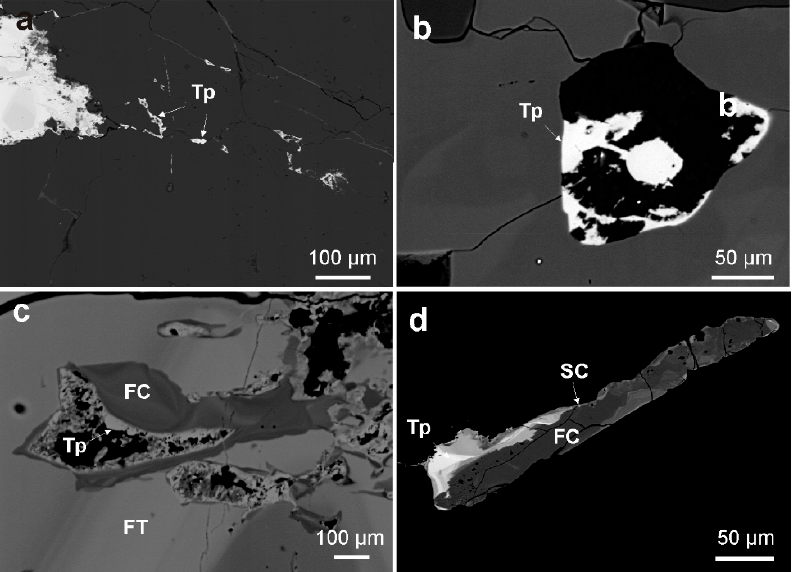
Figure 14. Textural patterns of tapiolite from type-IV pegmatites. ( a ) Tapiolite (Tp) filling fractures in quartz. ( b ) Tapiolite (Tp) filling a void in quartz produced by dissolution of a pre-existing mineral. ( c , d ) Replacement of columbite-(Fe) (FC) by tapiolite (TP) and stibiocolumbite (SC).